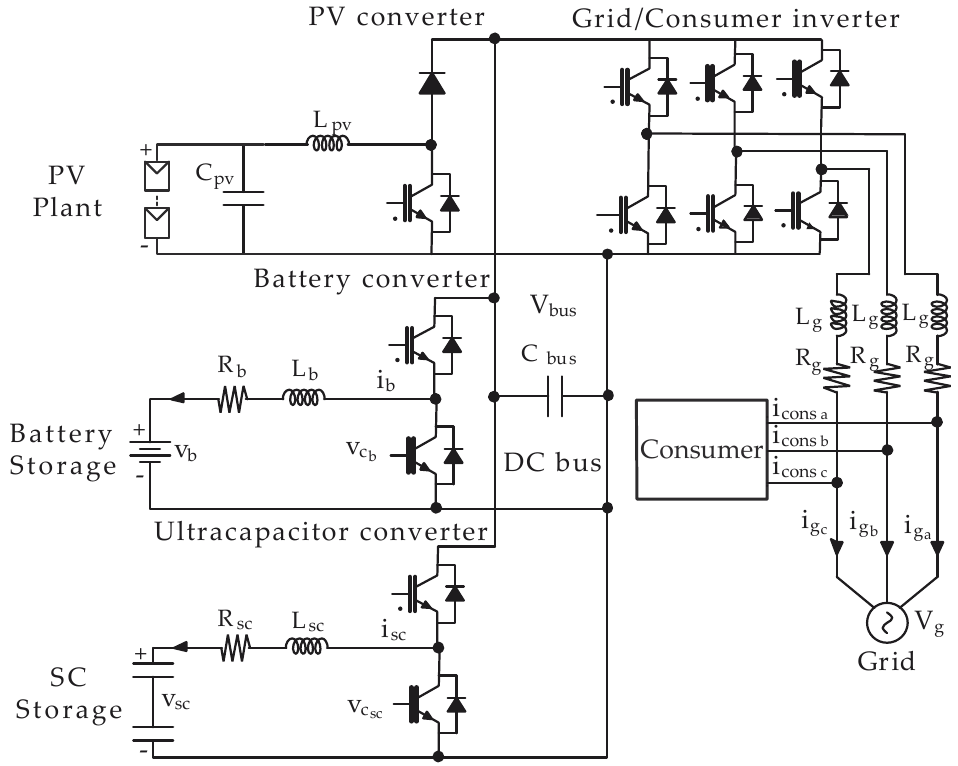
Figure 2. Detailed scheme of the Hybrid Renewable Energy System (HRES) for the injection of photovoltaic energy into the grid.